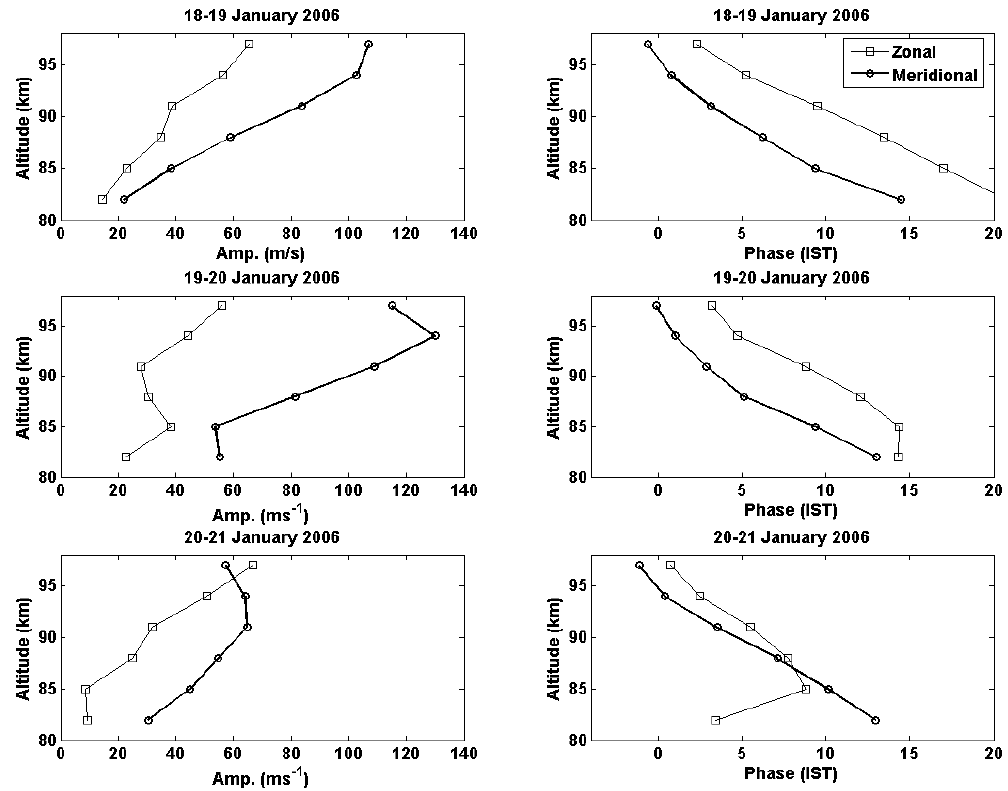
Fig. 4. Altitude profiles of amplitudes and phases of diurnal tide in meridional (curve with circles) and zonal winds (curve with squares) over Trivandrum for 19–20 February 2006 (top panels), 18–19 February 2006 (middle panels) and 20–21 February 2006 (bottom panels).